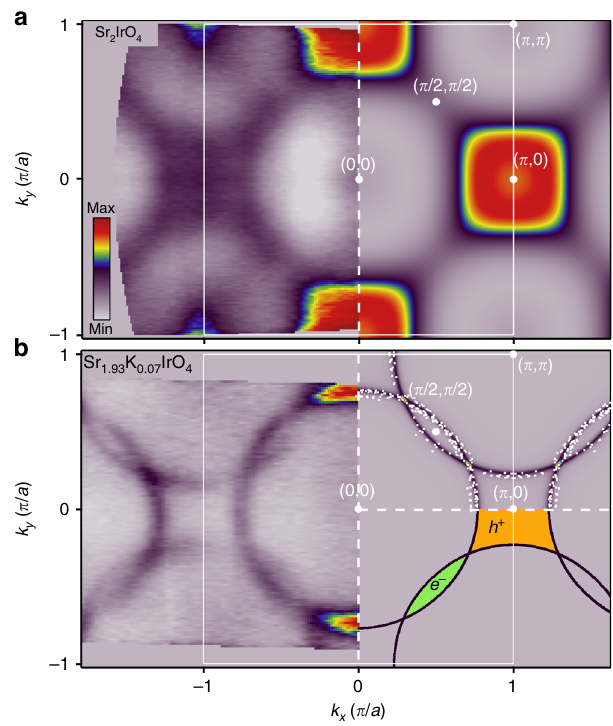
Fig. 2 Constant energy maps measured with h ν = 21.2 eV and simulated using tight-binding model. a Energy isosurface at E B = 0.3 eV for undoped Sr 2 IrO 4 (left) together with a broadened tight binding + spin – orbit coupling + U calculation, with U = 2 eV (right). All data are shown in a tetragonal Brillouin zone (1 Ir per unit cell), which ignores back-folding due to the in- plane octahedral rotations, which causes a b Fermi surface of Sr 1.93 K 0.07 IrO 4 showing ARPES data (left, averaged ± 20 meV around E F ) together with a tight binding and spin – orbit coupling simulation (right) with U = 0 eV; hole and electron pockets are shaded orange and green, respectively. Experimentally extracted k F s are shown as white dots on the tight-binding model